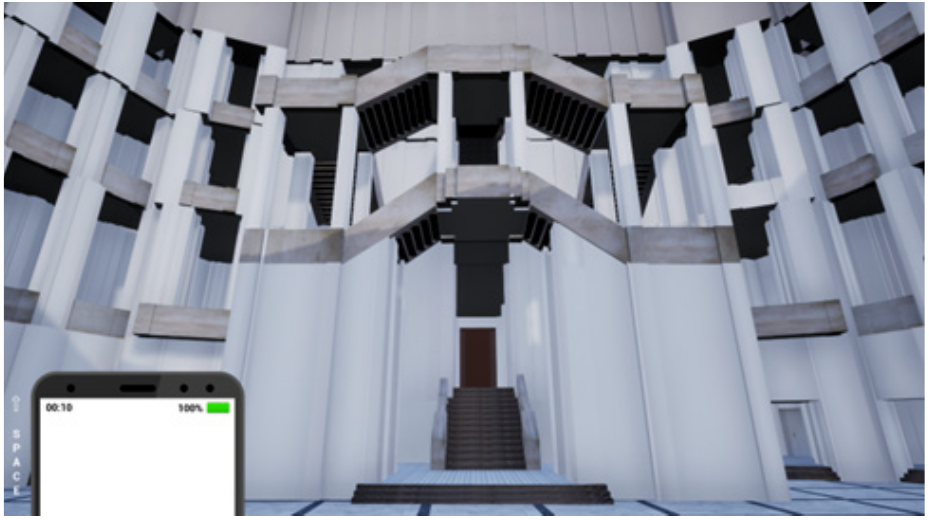
Fig. 2. First-person view inside the virtual